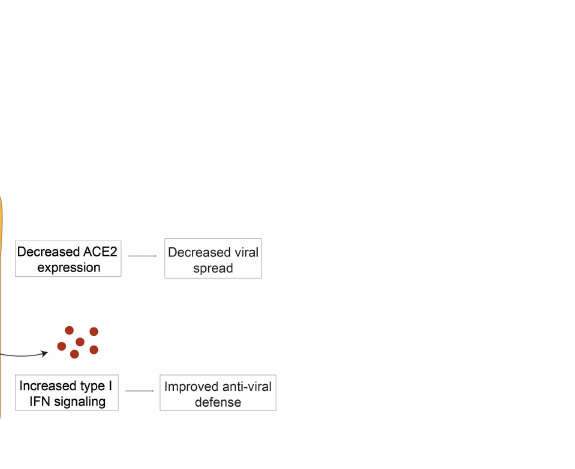
FIGURE 7 | Imiquimod treatment exerts anti-viral actions in human bronchial epithelium. Imiquimod exert dual actions on human bronchial epithelium: 1) Improves viral resistance by decreasing ACE2 expression (decreased viral spread) and increasing IFN- b expression (restored viral defense) on human bronchial epithelial cells (HBECs). 2) Potentiates viral infection tolerance by reducing viral stimulus-induced epithelial cytokines involved in severe COVID-19 infection (Prevention of cytokine